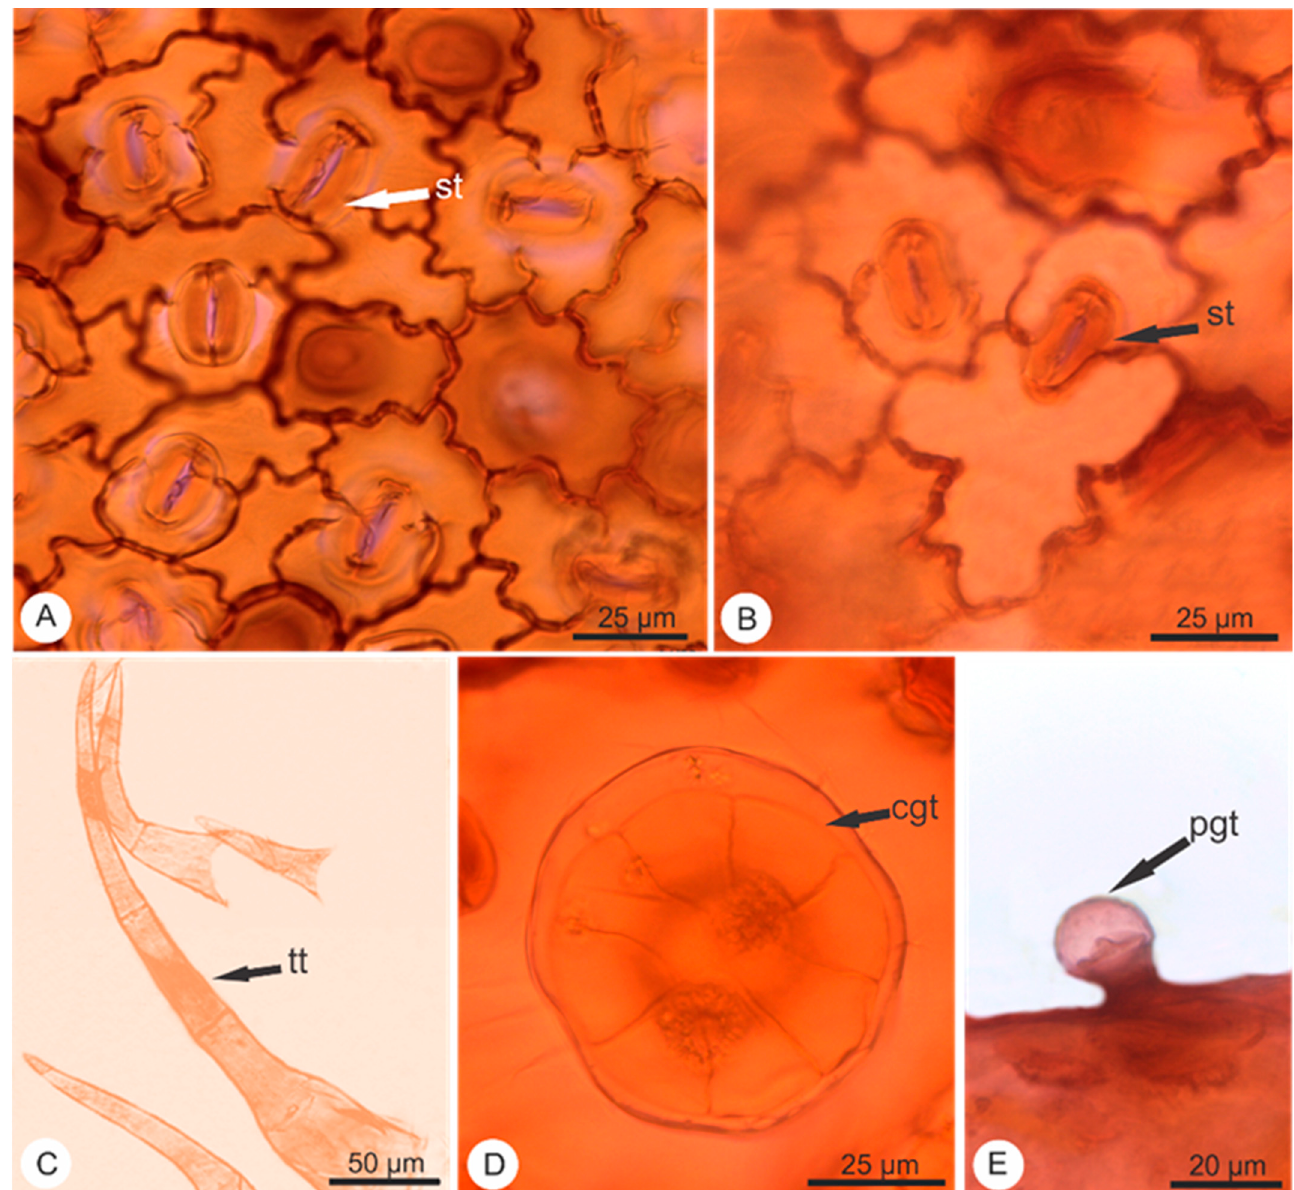
Figure 1. Light micrographs of epidermis of Elsholtzia ciliata (Thunb.) Hyl. ( A ) Adaxial surface with stomata anisocytic and diacytic; ( B ) Abaxial surface with detail of diacytic stomata. ( C ) Detail of multicellular tector trichome; ( D ) Detail of capitate glandular trichome; ( E ) Detail of peltate glandular trichome. Legend: capitate glandular trichome (cgt); peltate glandular trichome (pgt); stomata (st); multicellular tector trichome (tt).